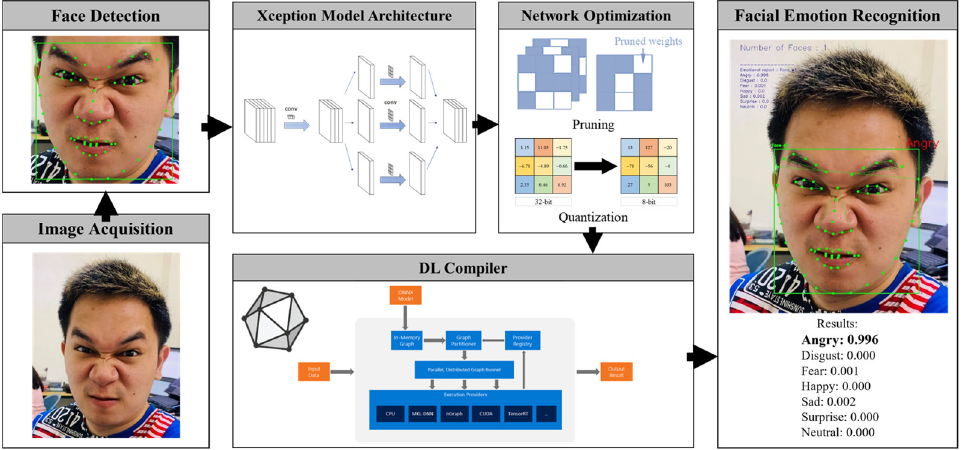
Figure 3. Schematic diagram of the proposed Light-FER system. First, we used a pre-trained landmark detector from the Dlib library to identify 68 key points or facial landmarks marked at specific x and y coordinates in the human